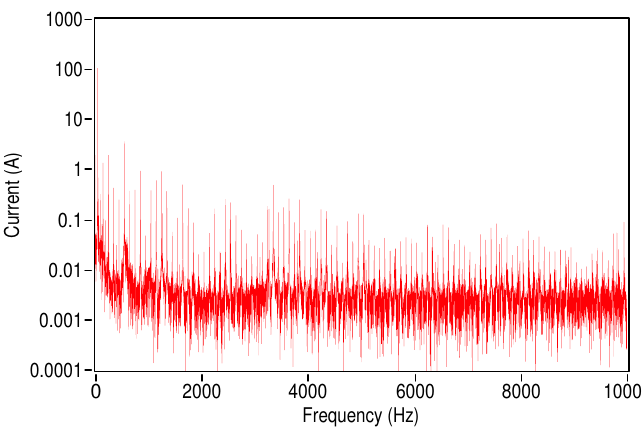
Figure 3. A typical current spectrum in 25 kV 50 Hz rail